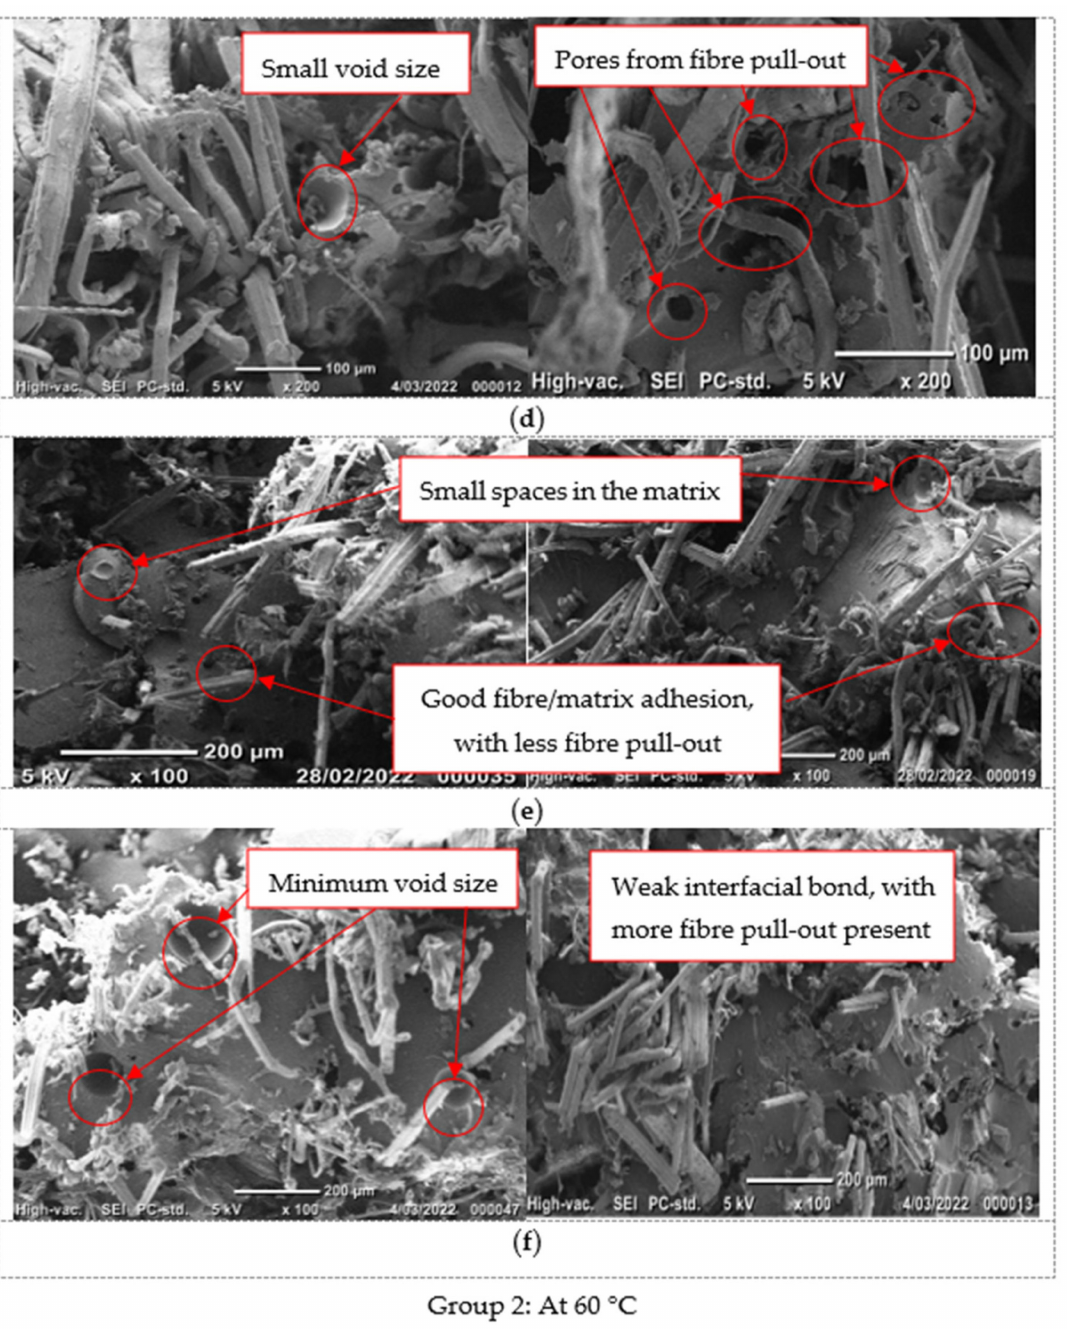
Figure 7. SEM images for specimens with various percentages of graphene: ( a ) Composite without graphene; ( b ) composite with 0.5%; ( c ) composites with 1% and 1.5% tested at RT; composites ( d – f ) with 0%, 0.5%, and (1%, 1.5%), respectively, tested at 60 ◦